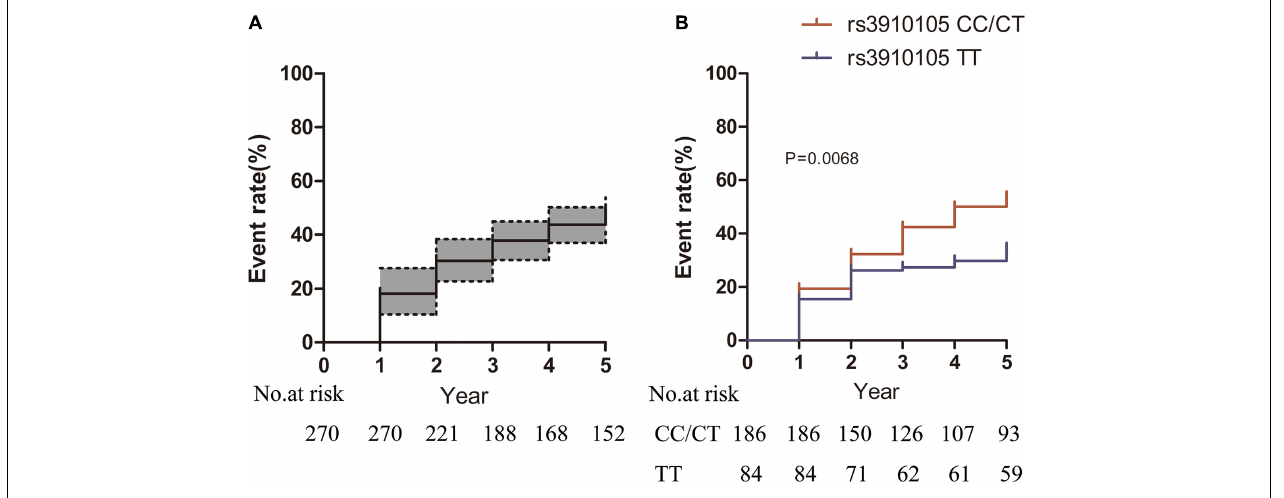
FIGURE 2 | Kaplan-Meier estimates showing the cumulative risk of RBD in (A) the total sample of patients and (B) the rs3910105 C carrier group and TT group. In panel (A) , dashed lines represent the 95% confidence interval range. In panel (B) , the red line indicates the rs3910105 C allele group, and the blue line indicates the TT group.